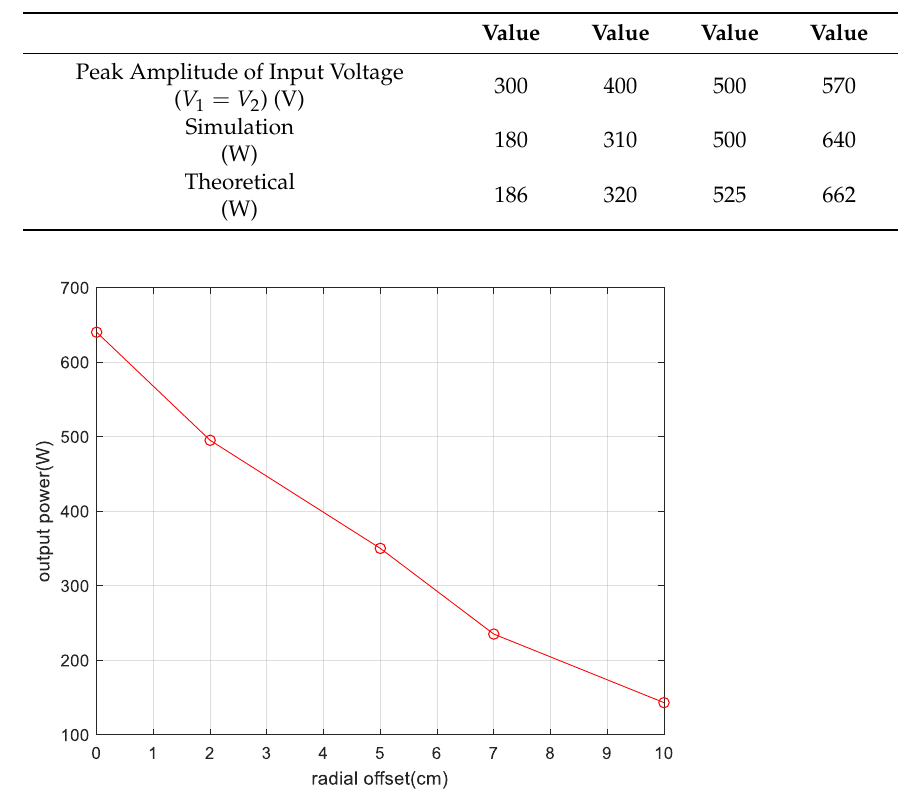
Table 2. Comparison of simulation and theoretical values of output power.